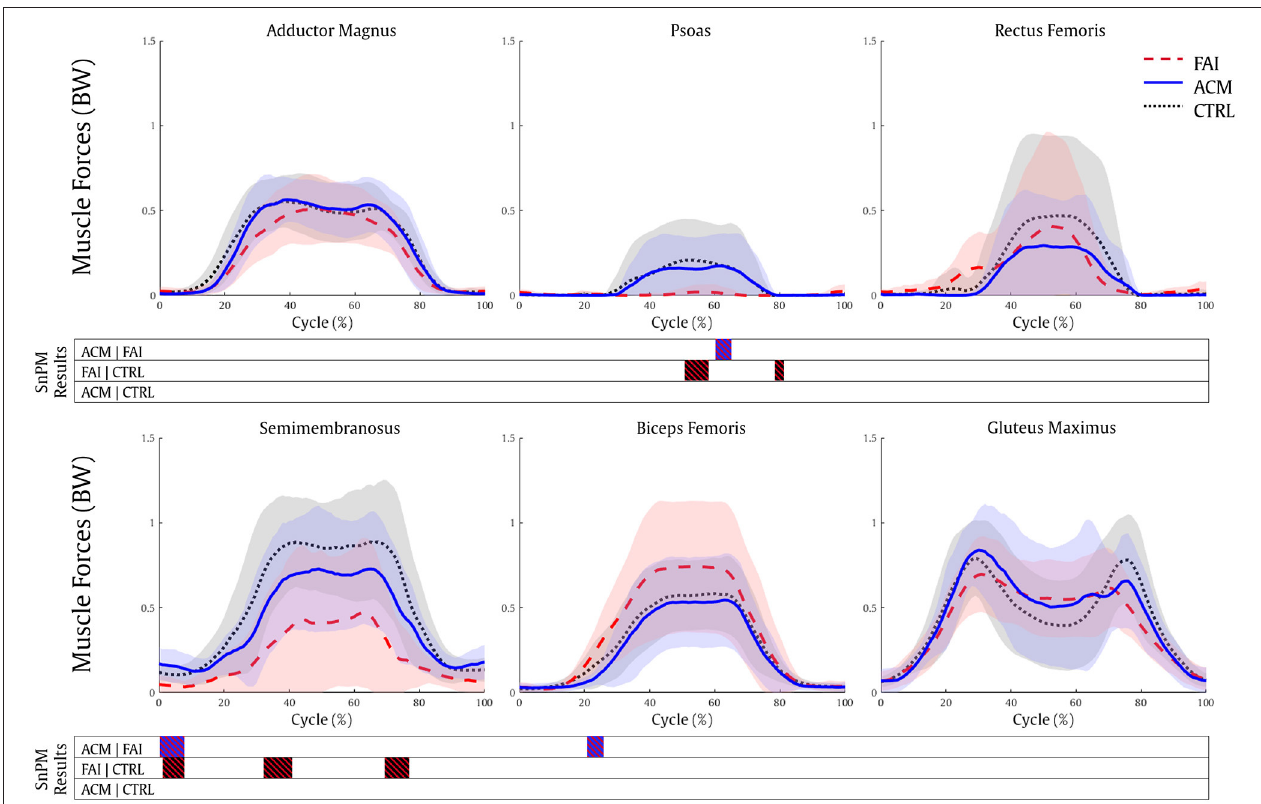
FIGURE 3 | Muscle forces during the squatting task for the FAI (dashed red), ACM (solid blue), and CTRL (dotted black) groups. SnPM results are displayed below the figure and indicate significant differences among the groups ( P ≤ 0.016). SnPM, statistical non-parametric mapping; BW, body weight; FAI, femoroacetabular impingement; ACM, asymptomatic cam morphology, CTRL, control. Shading indicates standard